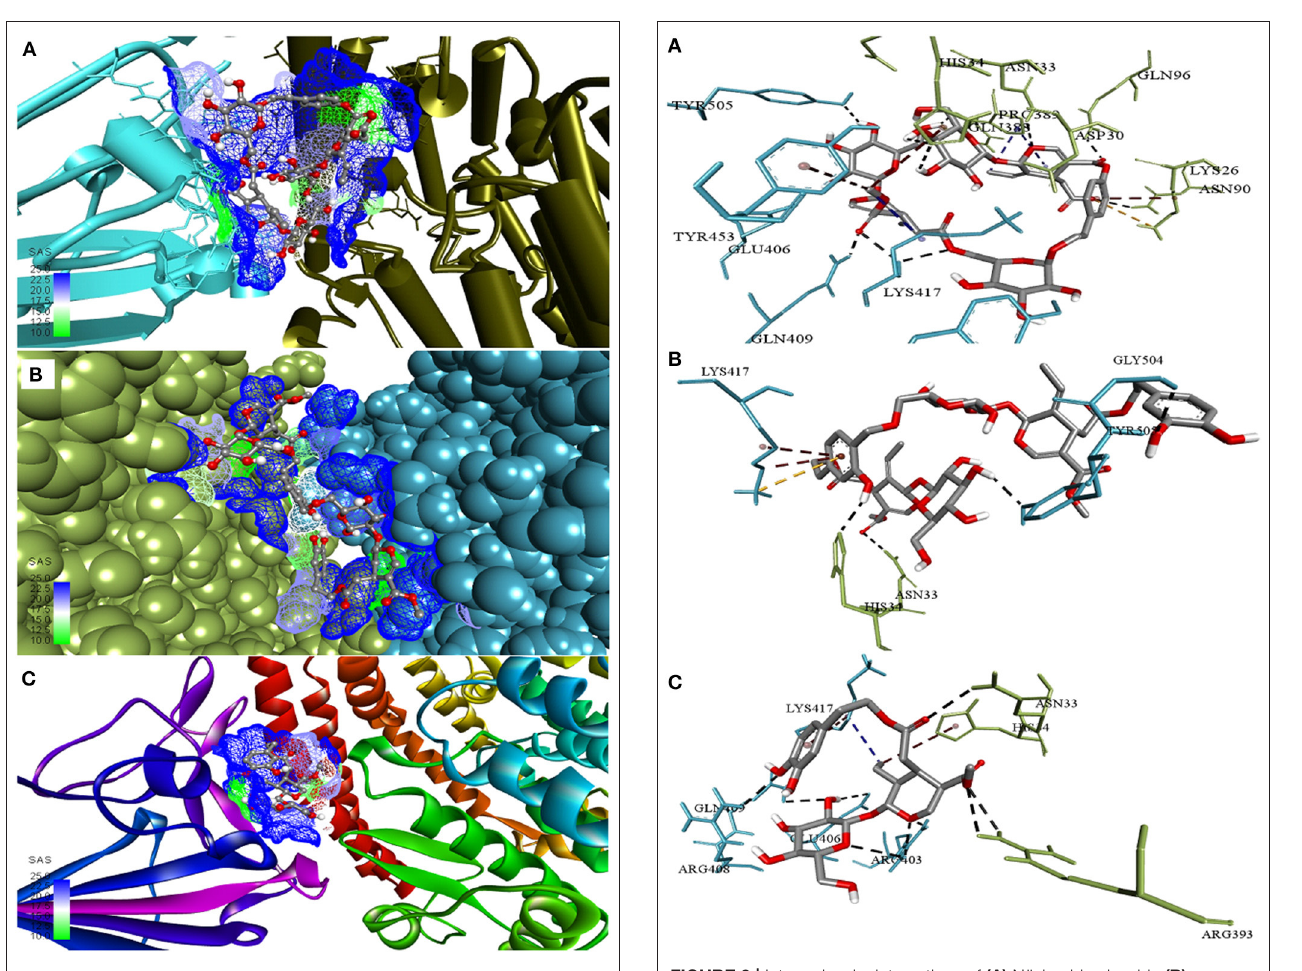
FIGURE 1 | Most active secoiridoids docked to the SARS-CoV-2 spike protein-ACE-2 interface. (A) Nüzhenide oleoside (B) Oleuropein dimer (C) Dihydro oleuropein. Mesh around the binding site represents it’s solvent accessible surface (SAS). All models show the spike protein in blue and ACE-2 in green. Panel (A) represents the SARS-CoV-2S protein-ACE-2 in their secondary structure forms, (B) represents targets in the CPK model, and ribbons in C represent targets.